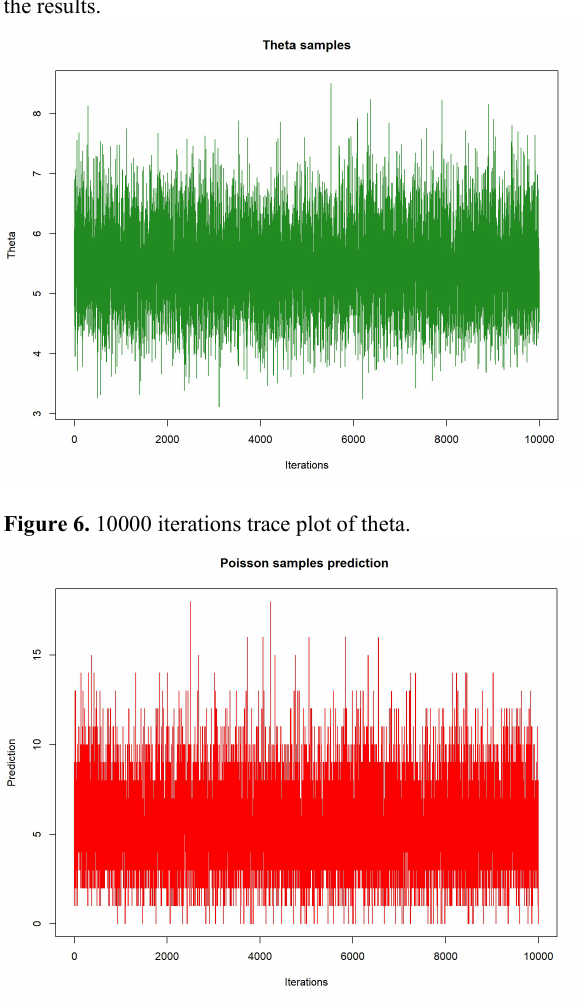
Figure 7. 10000 iterations trace plot of Poisson samples prediction of